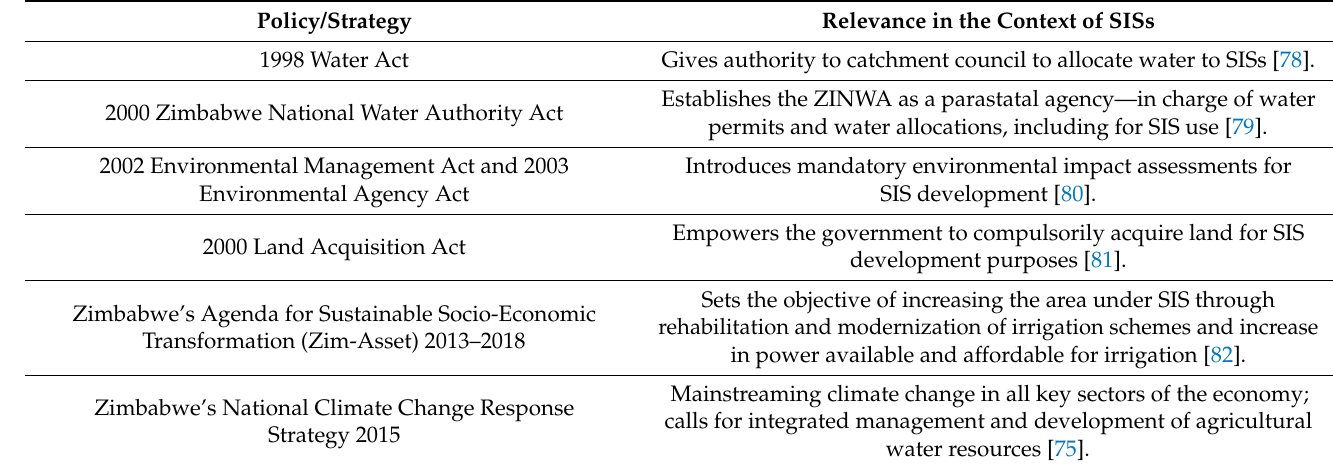
Table 3. Policies, programs and strategies relevant for SIS in Zimbabwe.